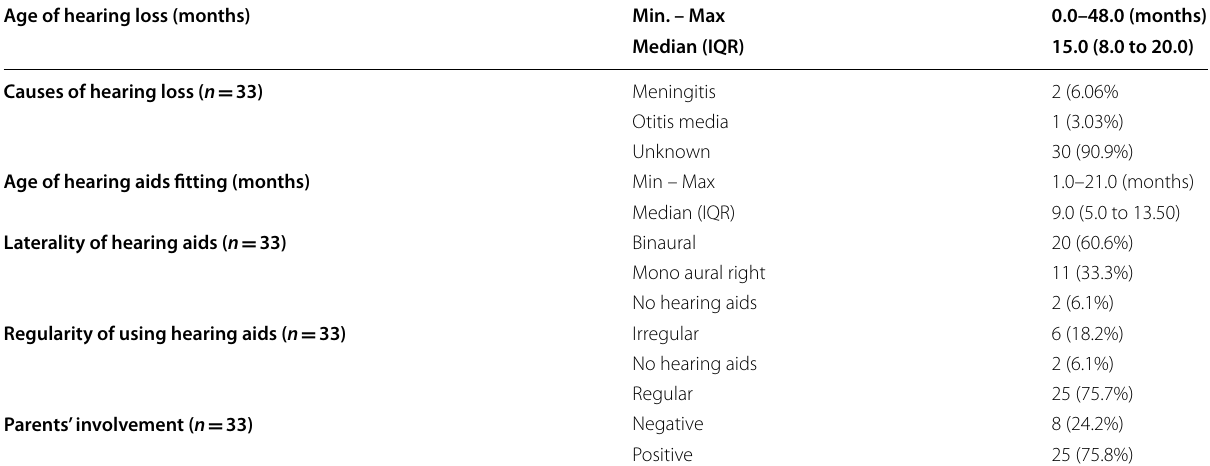
Table 2 Distribution of all studied cases according to demographic data